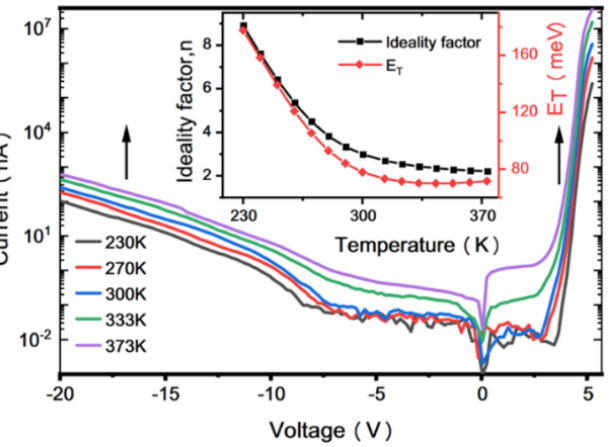
Figure 28. ( a ) The I-V curves of the 276 nm LED and ( b ) 306 nm LED. [56] Copyright 2022, Springer.